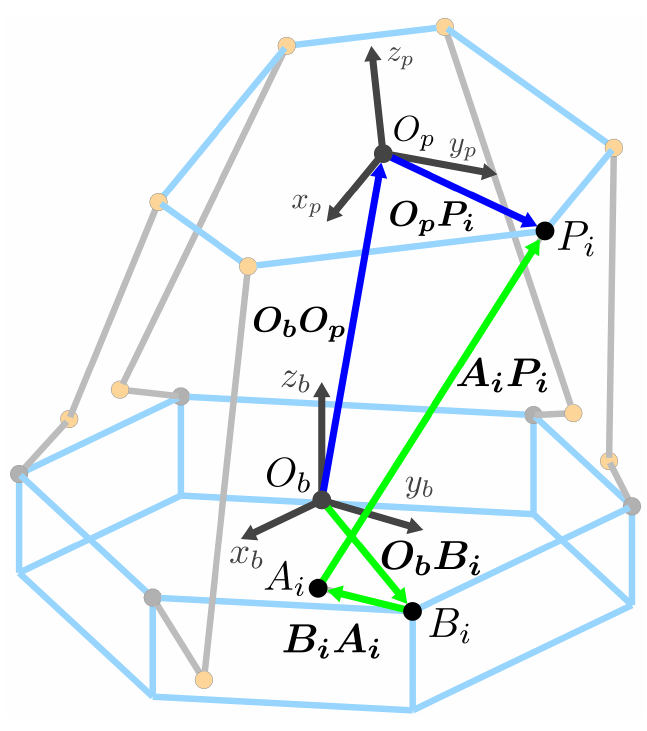
Figure 10. Single leg loop